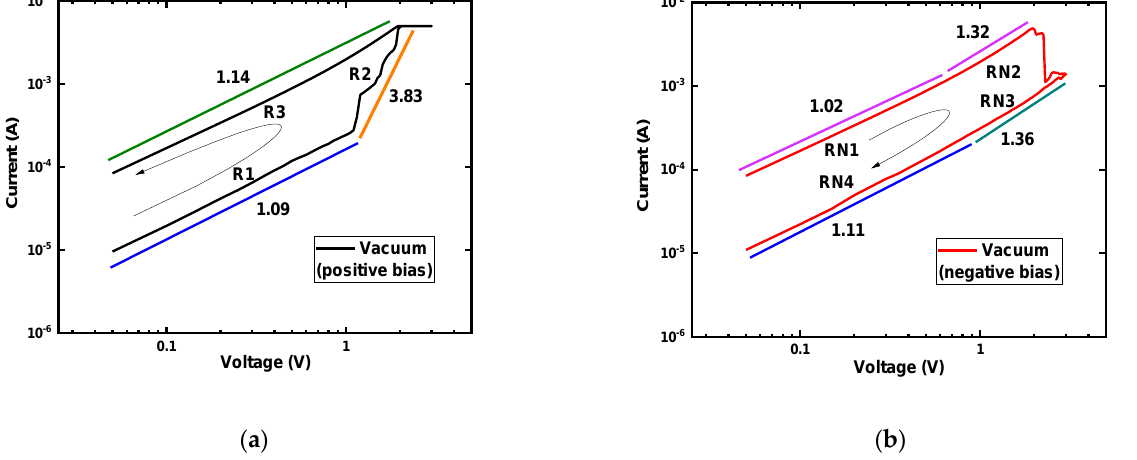
Figure 3. Log (I) − log (V) characteristics of Ti/MgF x /Pt memory devices with I cc = 5 mA in vacuum environment. ( a ) Positive bias voltage region; ( b ) Negative bias voltage region with slopes of different parts.